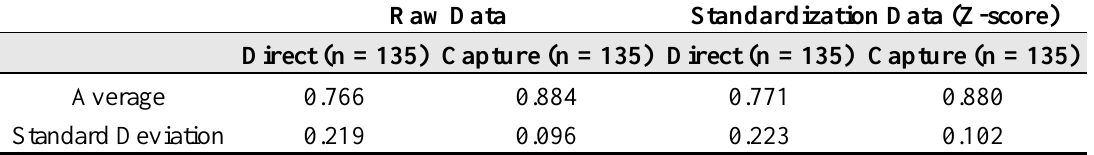
Table 4. Average of Correlation Coefficient ( r ) against ―Other Mushrooms‖ ( ex . Eryngii_1 vs.